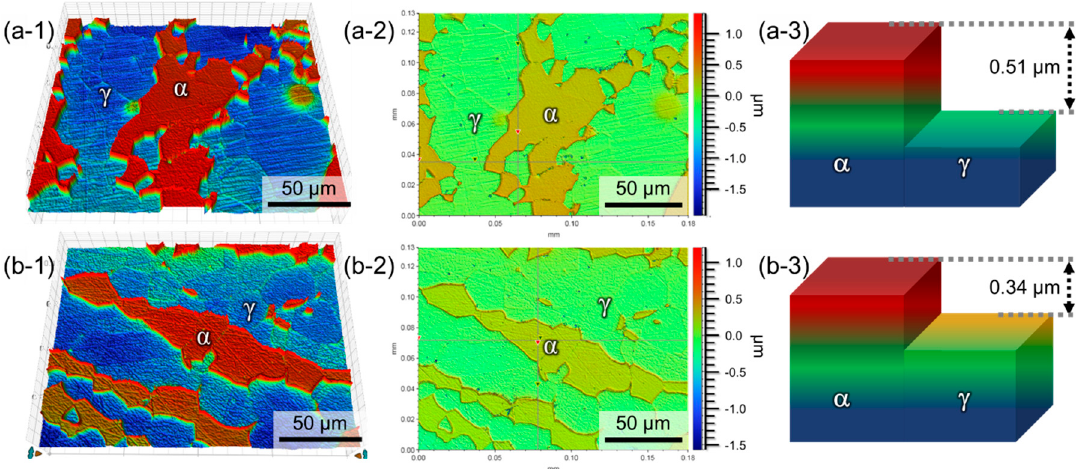
Figure 9. Three-dimensional topographs of the corroded surfaces of ( a-1 ) Ni03 and ( b-1 ) Ni57 alloys, and contour maps with a color scale bar of ( a-2 ) Ni03 and ( b-2 ) Ni57 alloys. The images were obtained after immersion in a 1 M HCl solution at 40 °C for 20 min. Schematic diagram of the corrosion depths of ( a-3 ) Ni03 and ( b-3 ) Ni57 alloys.